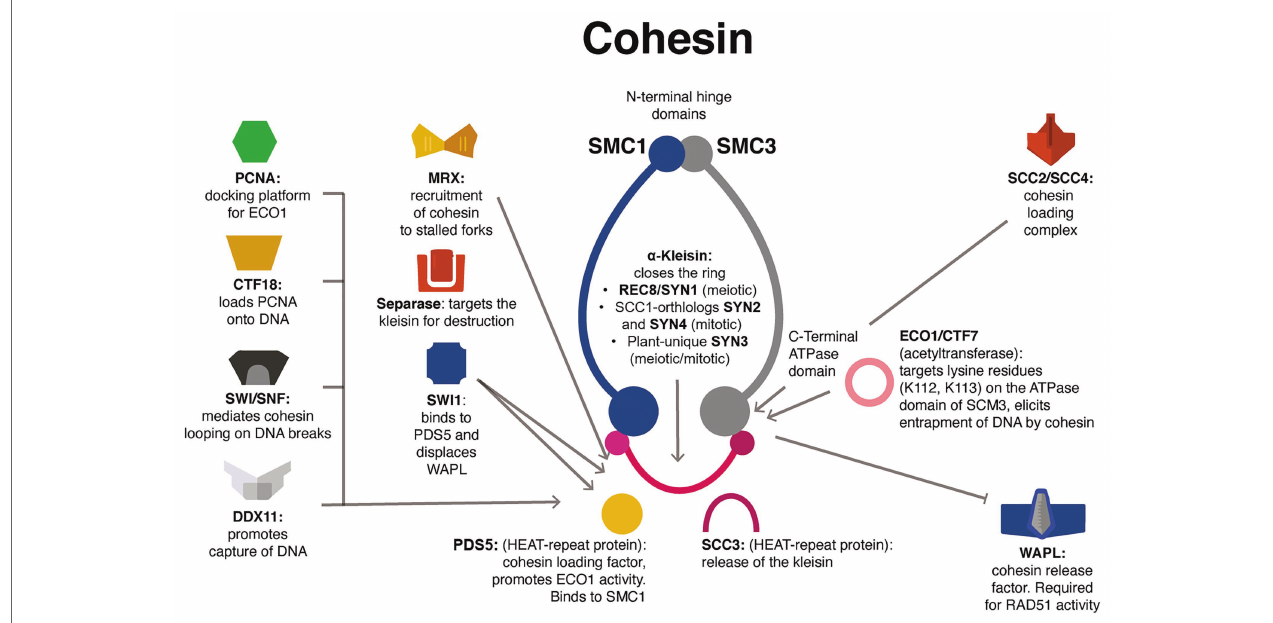
FIGURE 3 | Proposed simplified functional network between the plant cohesin complex and associated genome-maintenance factors. The cohesin complex performs a wide repertoire of functions including homologous recombination during meiosis and mitosis. The complex is loaded onto chromatin by SCC2/SCC4; it is stably locked onto chromatids by ECO1/CTF7, an acetyltransferase that targets lysine residues on the ATPase domains of SMC3 (and possibly SMC1); and entrapment of DNA is promoted by factors such as PDS5 and SWI1 and antagonized by WAPL and SCC3, which may target the meiotic α -kleisin REC8/SYN1 or the mitotic α -kleisin SCC1, which in Arabidopsis is represented by orthologs SYN2 and SYN4, while SYN3 is unique to plants and is both meiotic and miotic. The Separase (ESP1 in Arabidopsis ) also targets kleisins for degradation. Several other factors promote its function, such as PCNA during homologous recombination; CTF18, which might promote its loading onto DNA; DDX11, which might promote capture of DNA; SWItch/sucrose non-fermentable (SWI/SNF) complexes that promote cohesin-mediated looping on DNA breaks; and the MRX complex that promotes recruitment of cohesin on replication forks that stall. Characterization of these processes in plants may facilitate the understanding of meiosis, DNA repair, and genome